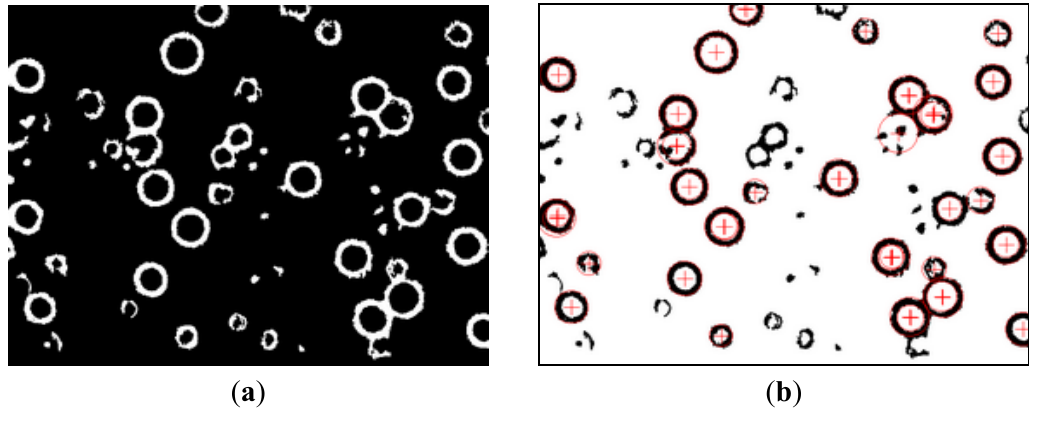
Figure 4. ( a ) The image after NI IMAQ Removed Particle, ( b ) The image after NI IMAQ Detected Shapes (black and white as opposite to original image).